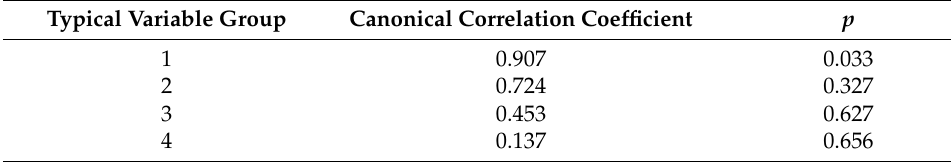
Figure 4. Correlation plots for cases that had a significant correlation between stand structure and understory herbaceous plants species diversity. Table 3. Canonical correlation coefficient and its significance